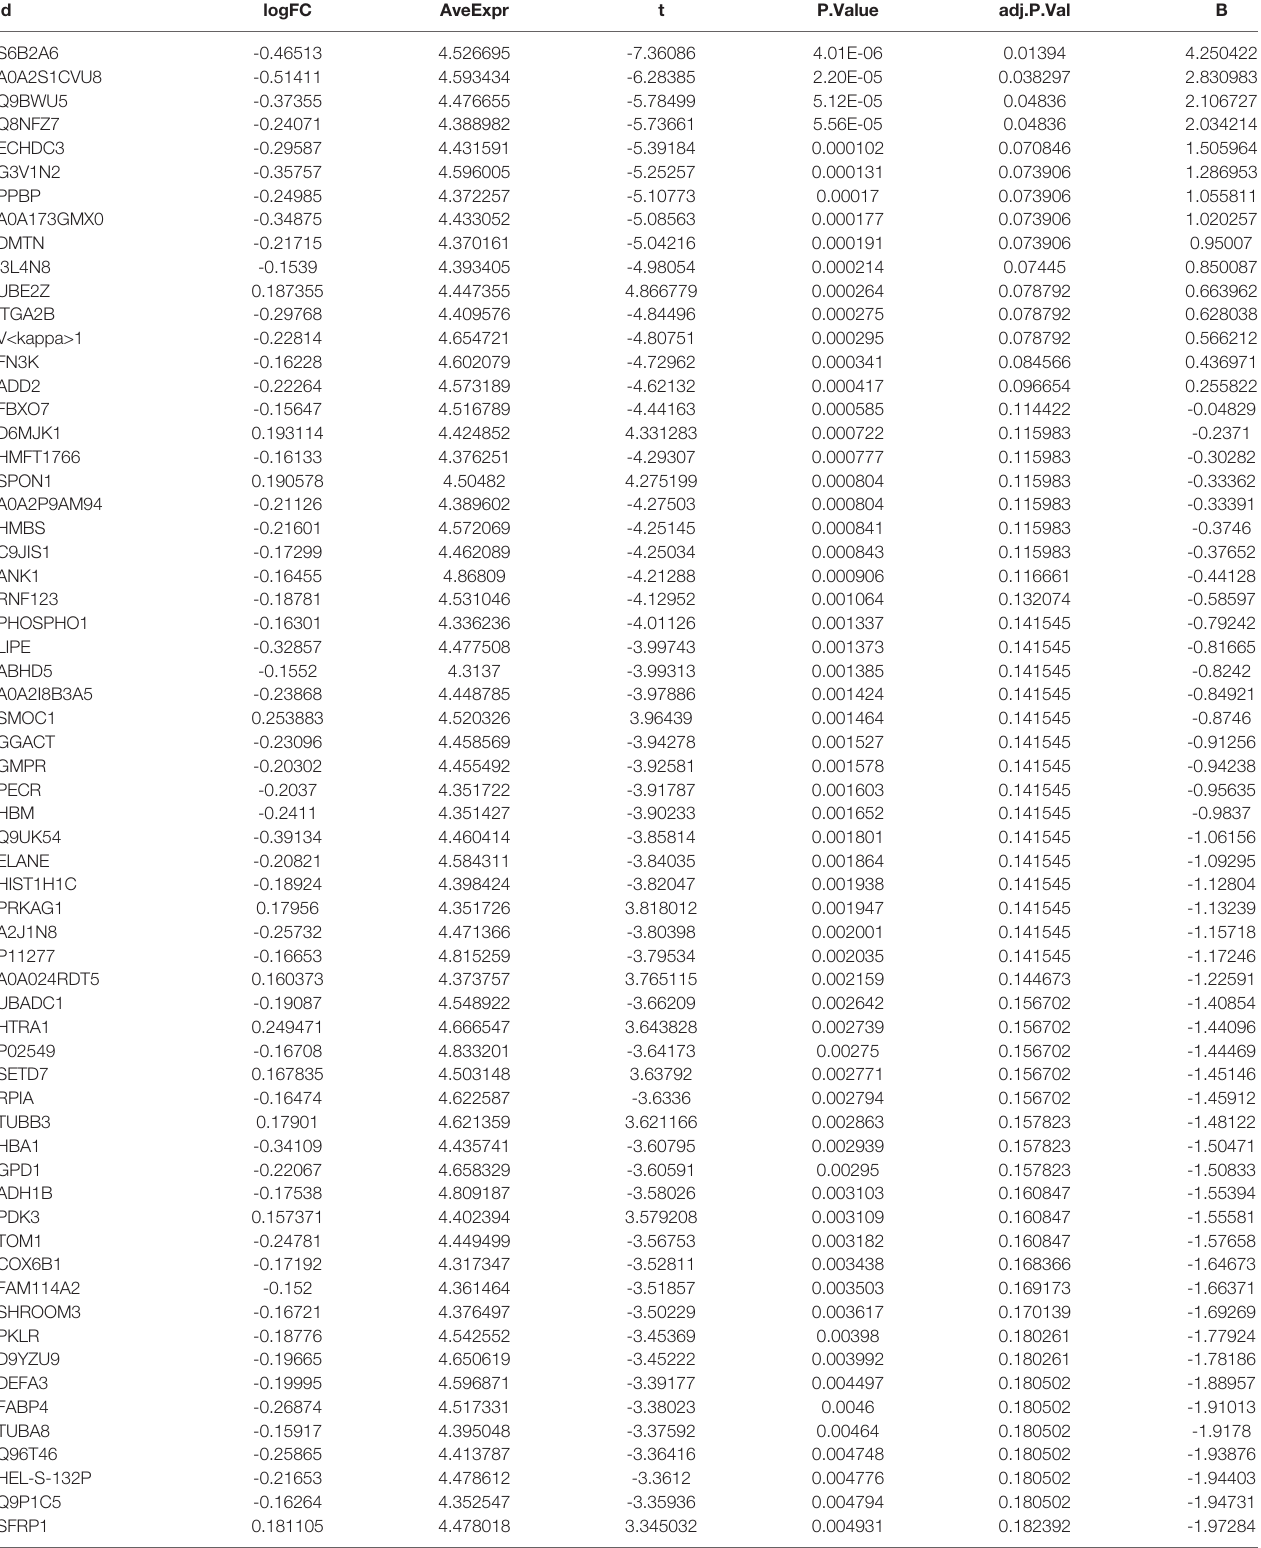
TABLE 1 | Details of differentially expressed